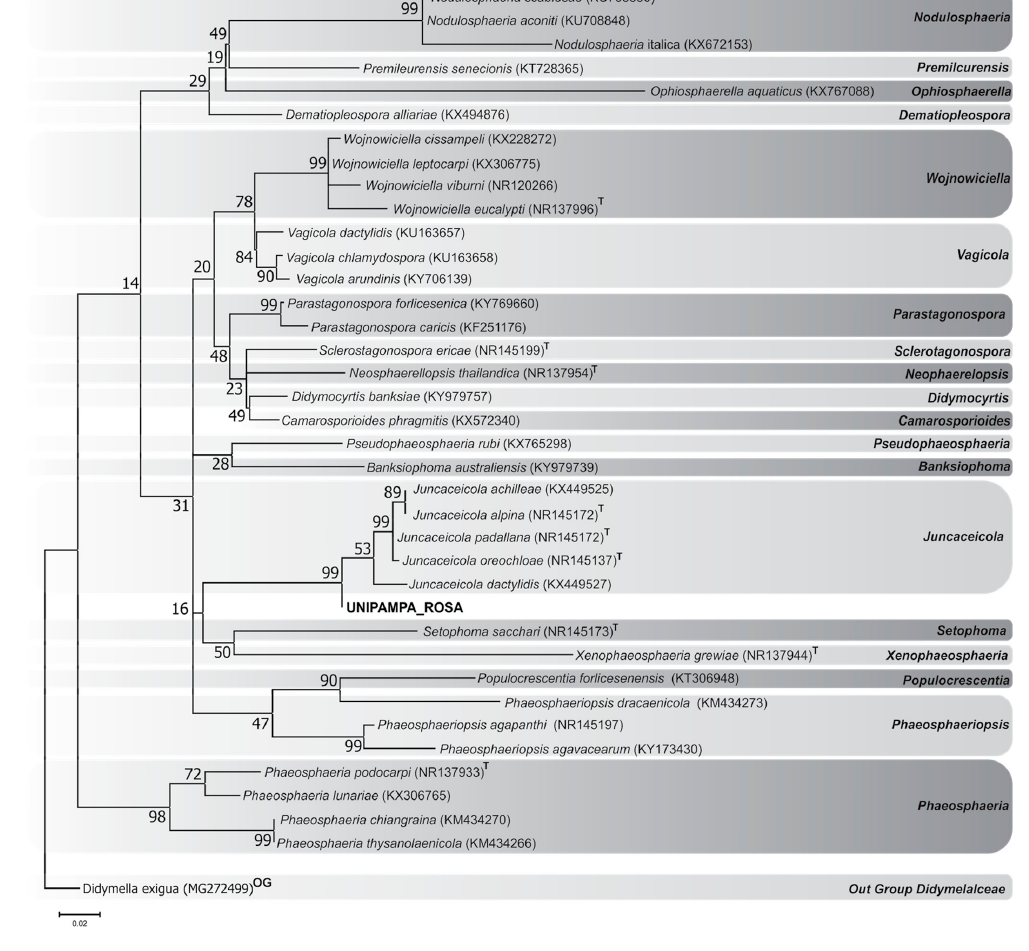
Figure 2. Maximum Likelihood (ML) consensus tree showing the relationship among Deschampsia antarctica endophytic fungi (UNIPAMPA_ROSA) and other fungal sequences belonging to the Phaeosphaeriaceae family, following BLAST analysis. The tree was constructed using GenBank data based on rDNA (ITS1-ITS4) fragment sequence using MEGA version 7 with a maximum likelihood method (bootstrap values are shown at nodes). The tree is rooted to Didymella exigua (CBS 183.55). The sequences of type species are indicated as superscript